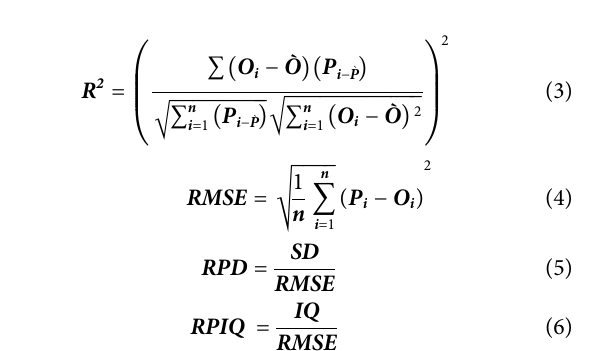
FIGURE2 | Sample organic matter content statistics (A: Gurbantunggut Desert, B: Mu Us Sandy Land, C: Taklimakan Desert, D: Minqin Oasis-Desert transition belt, E: Gonghe alpine deserti fi ed grassland, F: Otindag Sandy Land, G: HorqinSandyLand,H:HulunbuirSandyLand,errorbars:standarddeviation).